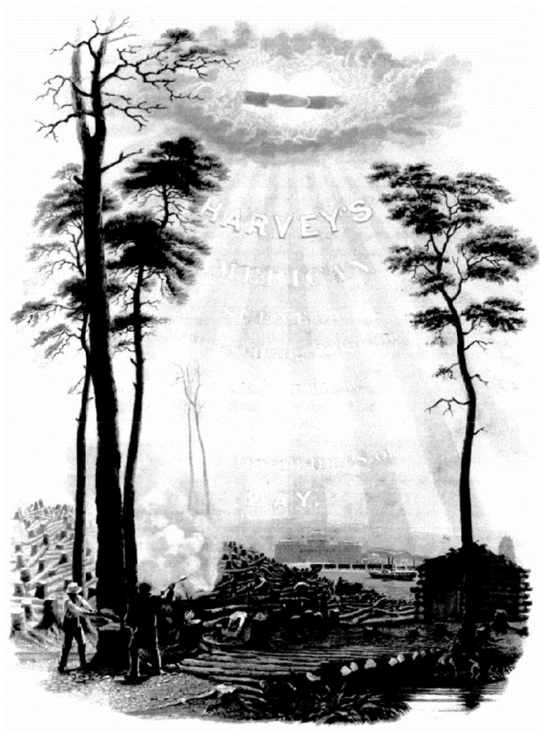
Figure 4. Epitome of the Historic Progression of the United States by William Harvey 1841. Engraving, title page of George Harvey, Washington Irving, W. J. Bennett, and Charles Vinten’s Connected Series of Forty Views of American Scenery . 1841. New York: Charles Vinten.